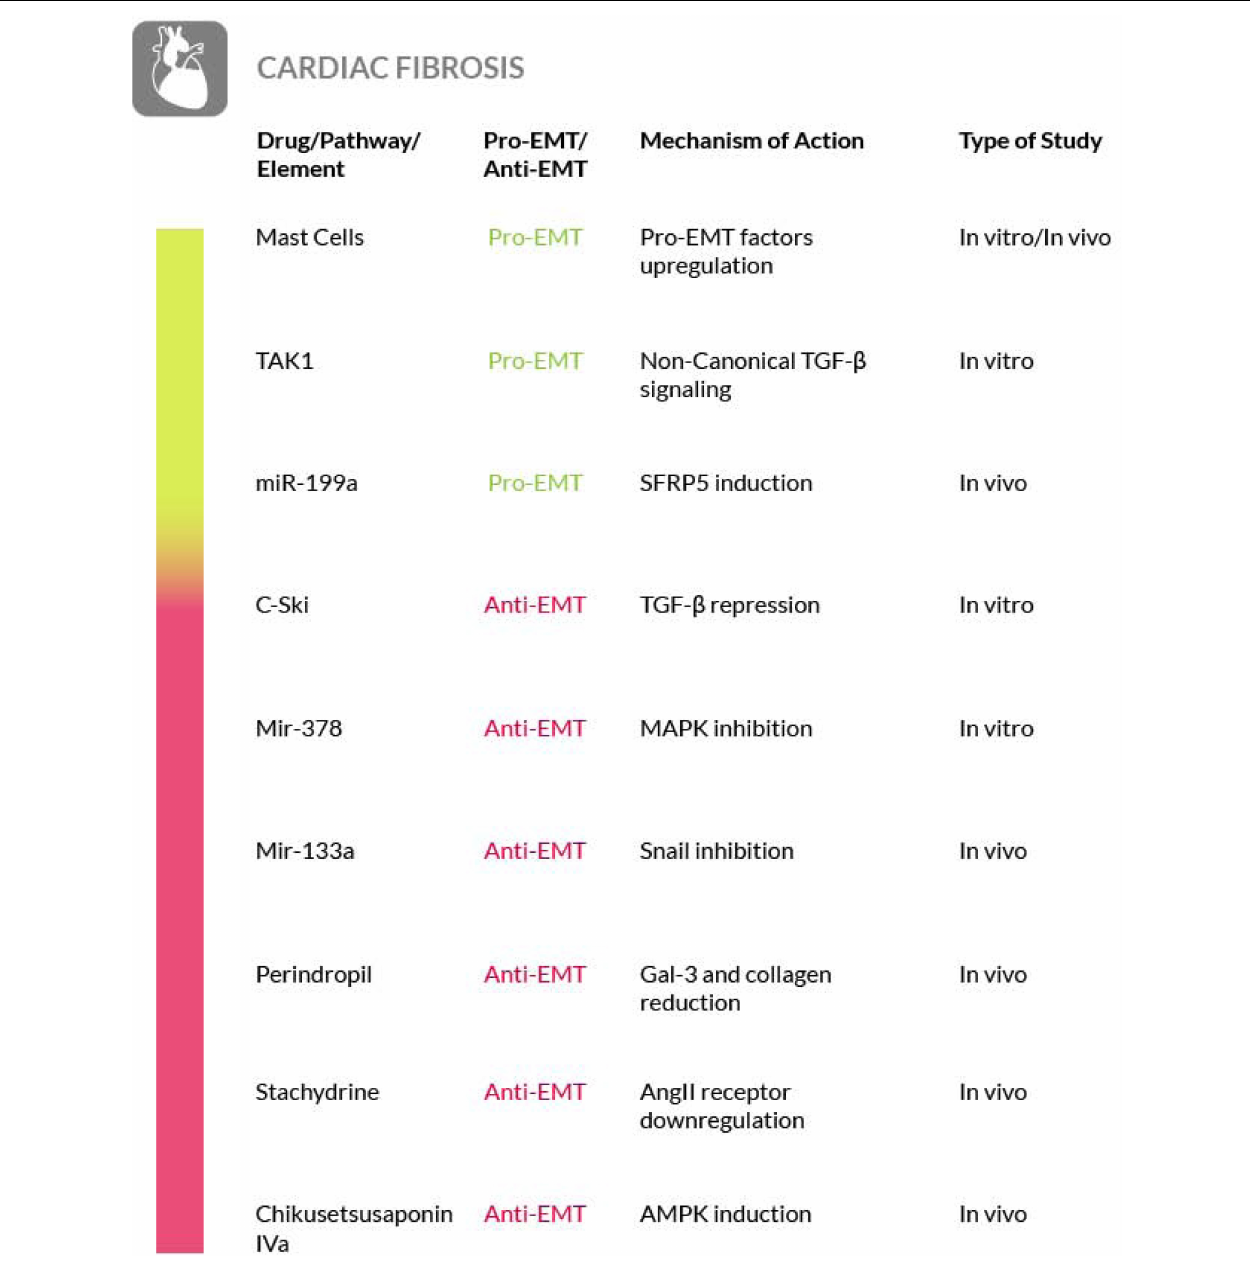
FIGURE 11 | Most relevant molecular mechanisms and possible drugs for the treatment of EMT in cardiac